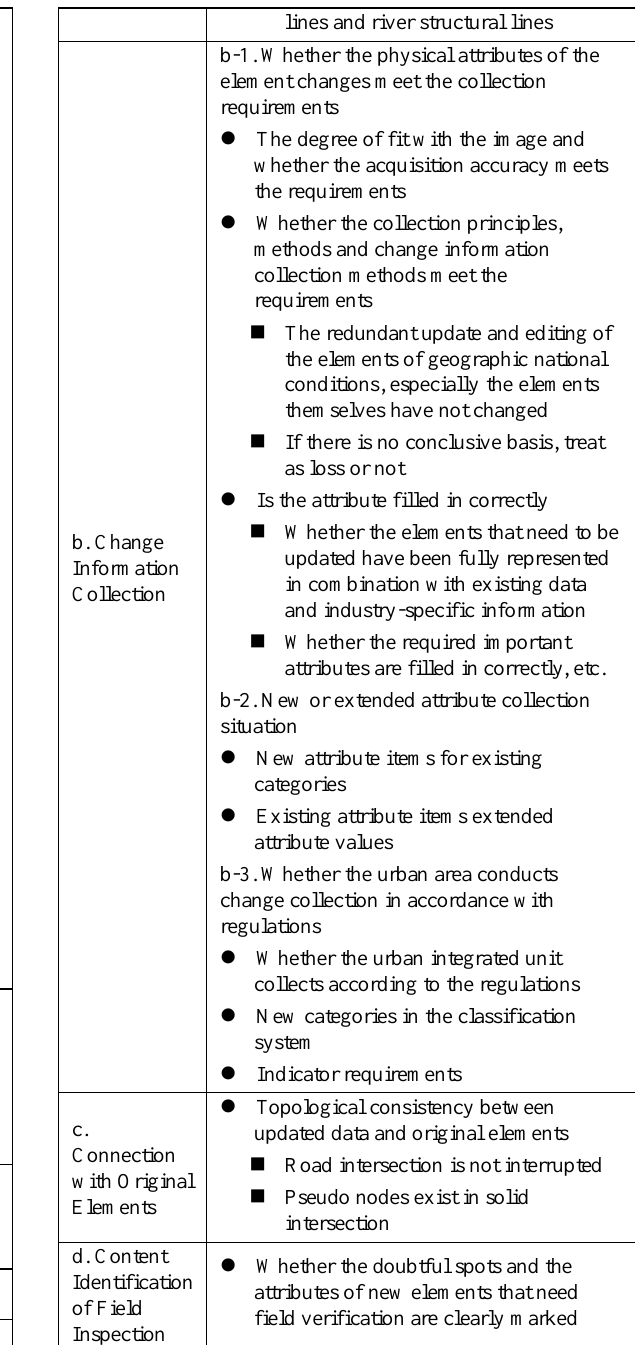
Table 1 . Specific content of process quality inspection (take change information collection as an